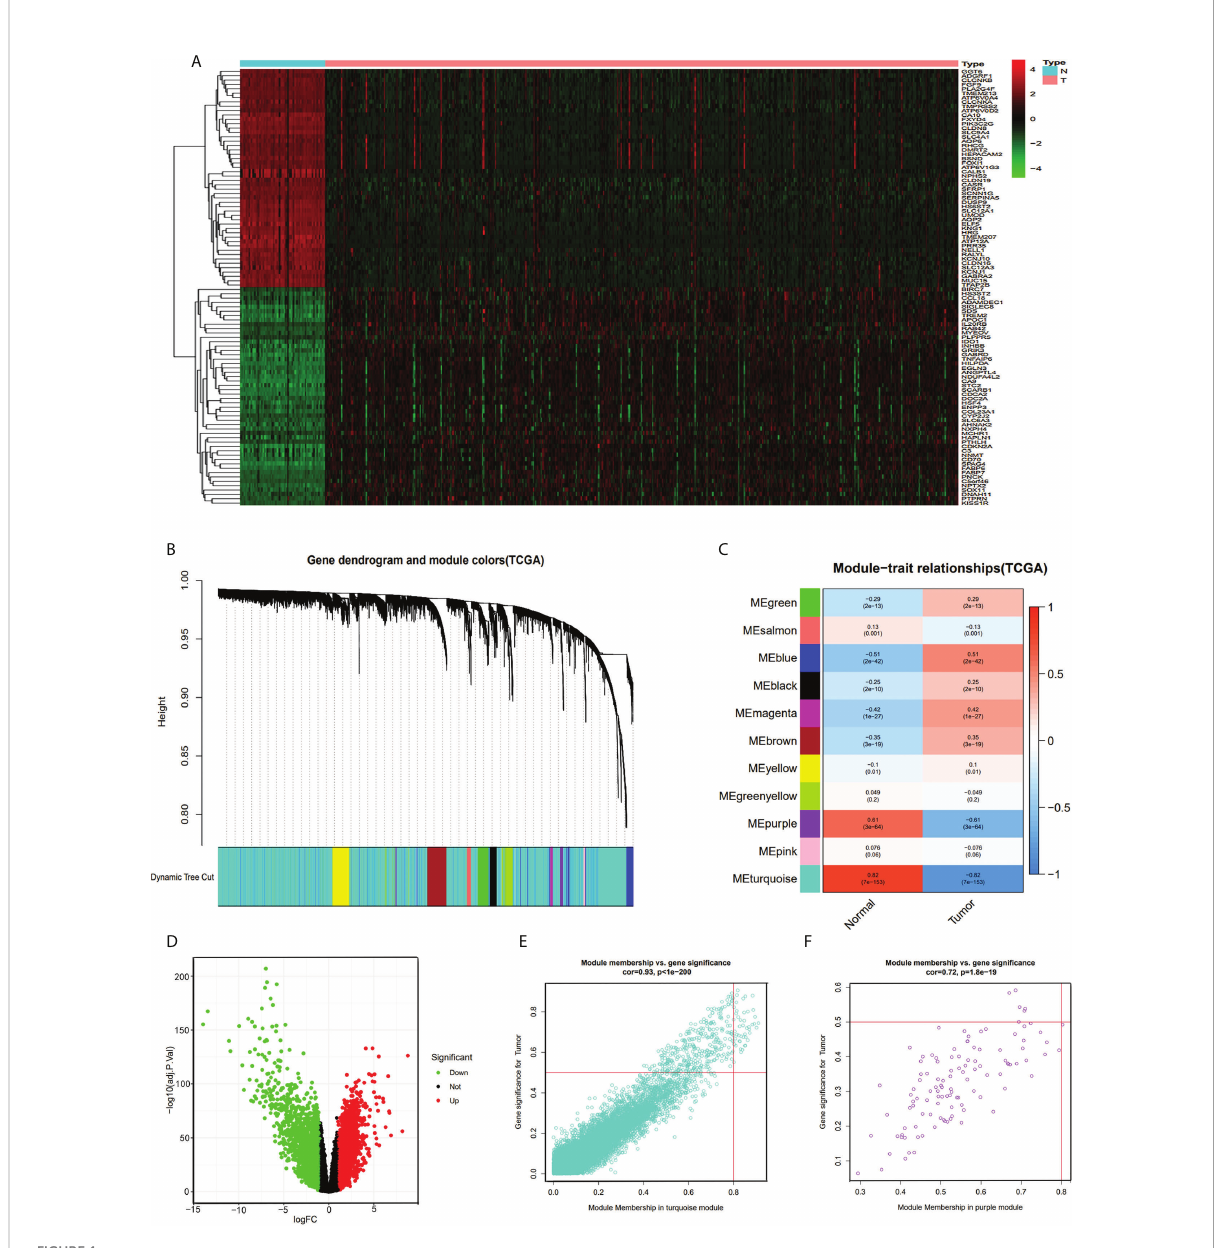
FIGURE 1 DEG and WGCNA analysis of TCGA-KIRC dataset. (A) Heatmap of top 100 DEGs between ccRCC and normal renal tissue from TCGA-KIRC dataset. (B) Clustering dendrograms of all the genes of TCGA-KIRC, based on the difference in topological overlap, assigned modules with different colors. (C) The eleven co-expression modules and the module trait between ccRCC and normal renal tissue. (D) Volcano Plot of 14,684 genes of TCGA-KIRC dataset. Green assigned downregulated genes and rad assigned up. (E) Module membership in the turquoise module. (F) module membership in the purple